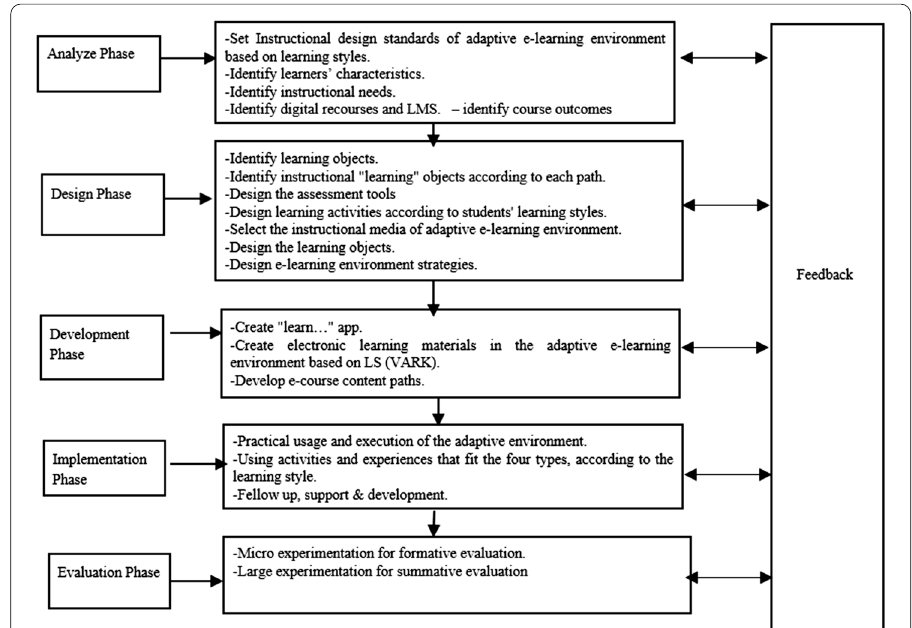
Fig. 3 The ID (model) of the adaptive e‑learning environment